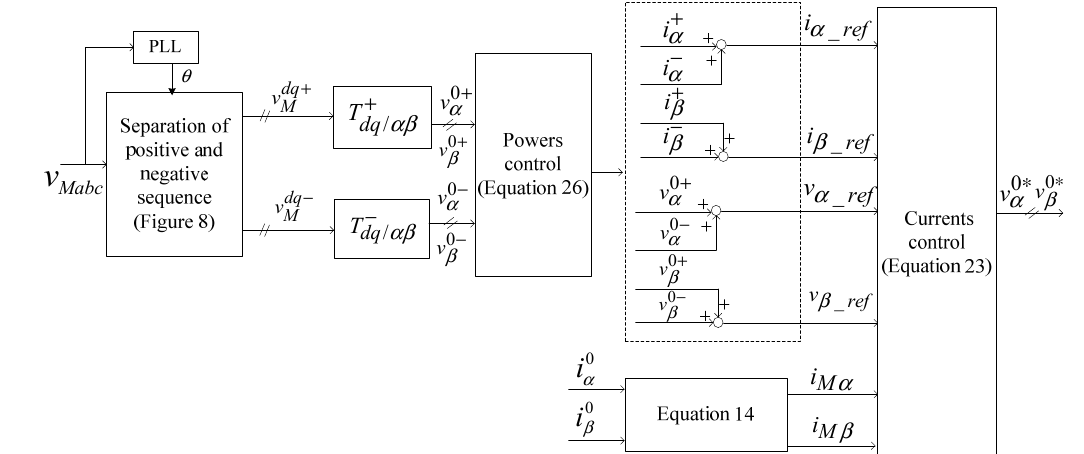
Figure 10. Control block diagram of the secondary side system.